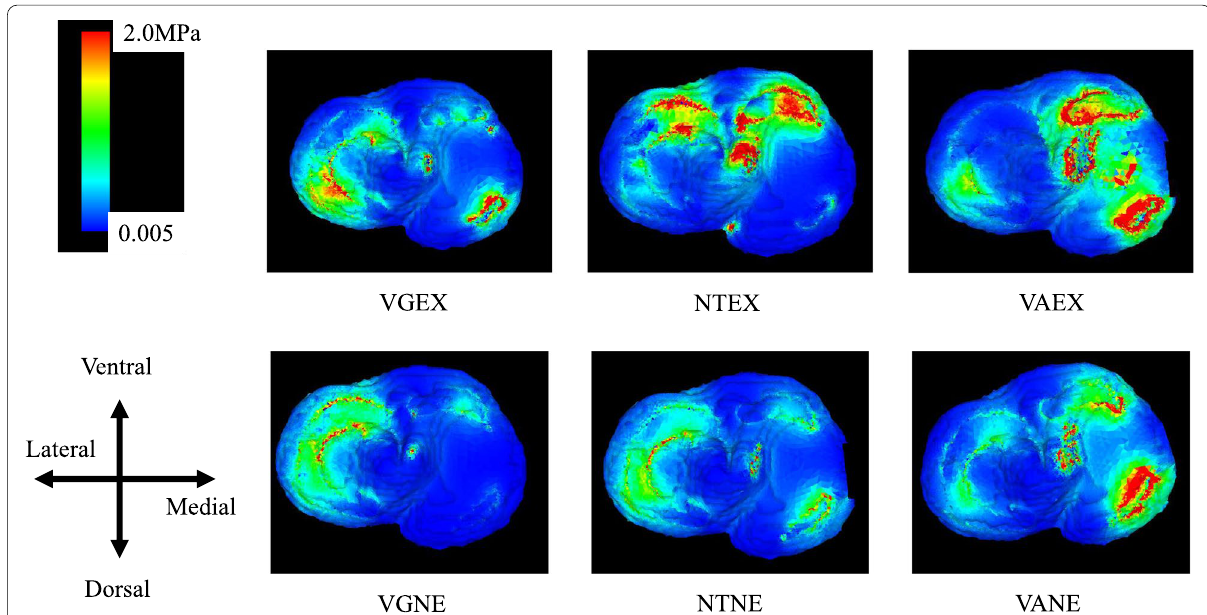
Fig. 3 Axial view of the knee cartilage on the tibial side showing von Mises stress. The von Mises stress was most concentrated in the medial cartilage on the tibial side in the VAEX models, followed by that in the VANE model. VGNE; valgus and non-extrusion of medial meniscus, VGEX; valgus and extrusion of medial meniscus; NTNE; neutral and non-extrusion of medial meniscus, NTEX; neutral and extrusion of medial meniscus, VANE; varus and non-extrusion of medial meniscus, VAEX; varus and extrusion of medial meniscus